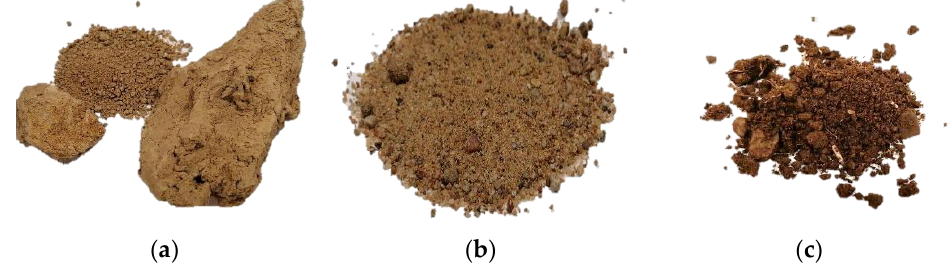
Figure 2. View of soil samples: ( a ) No. 1, ( b ) No. 2, ( c ) No. 3. Table 1. Description of the location of measurement points.